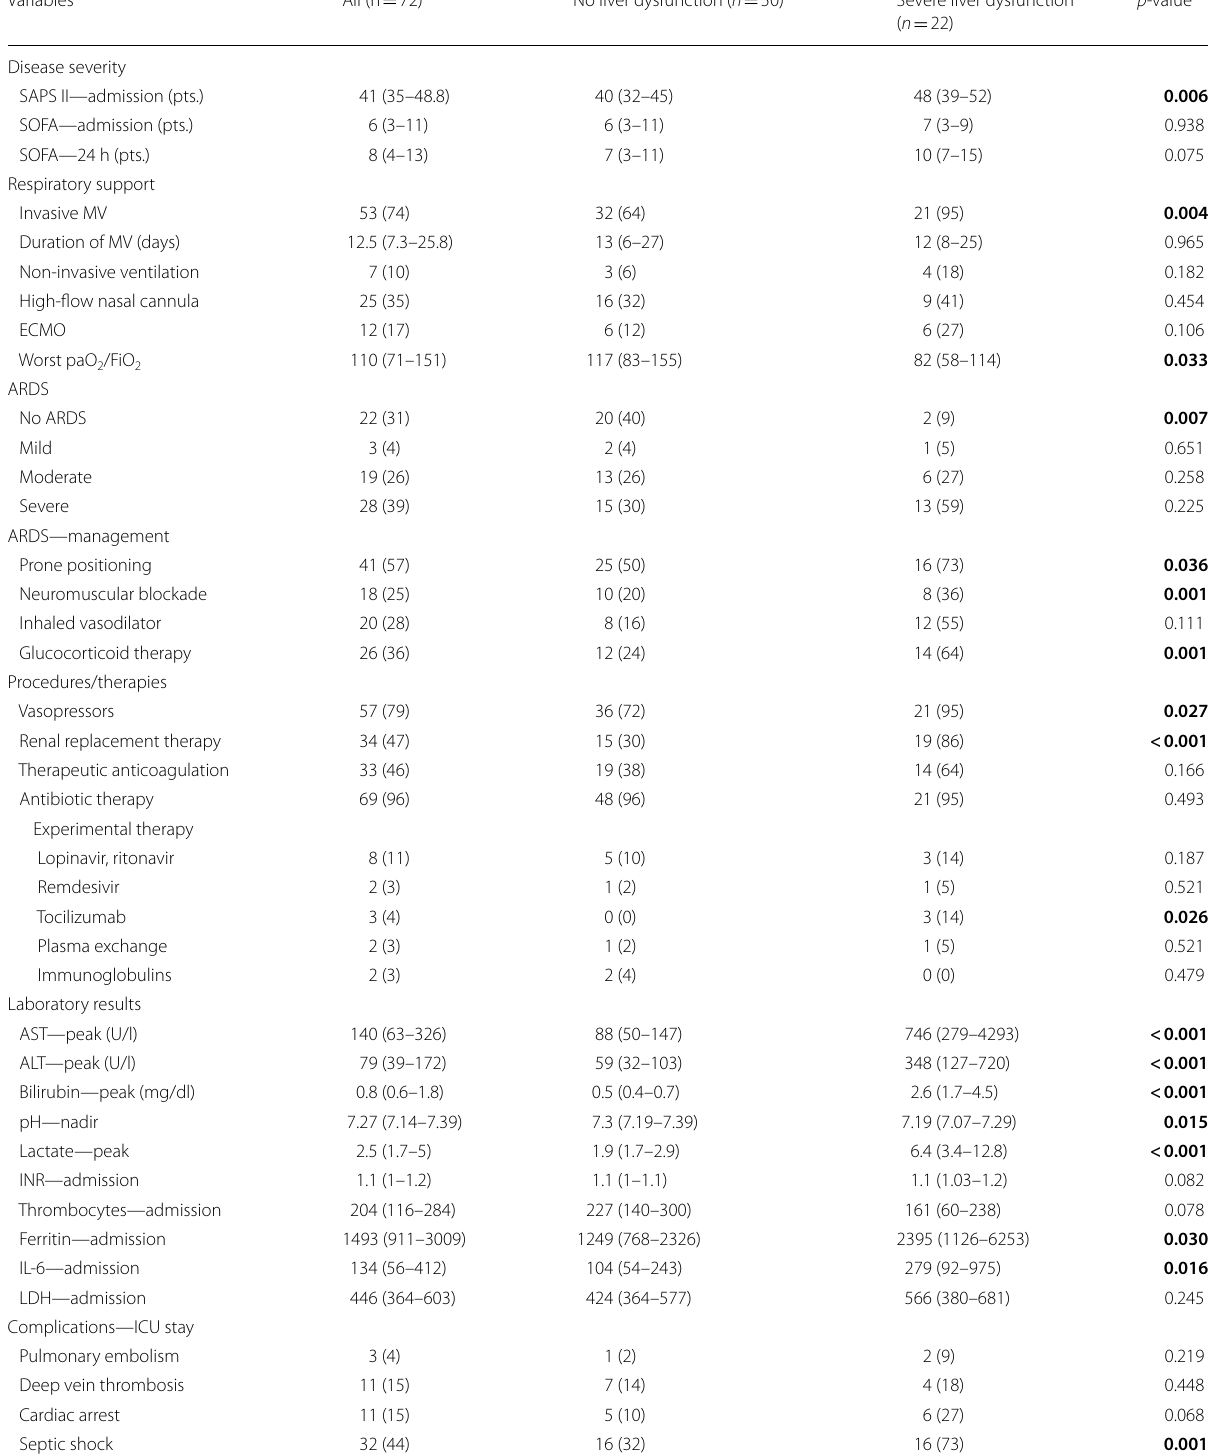
Table 2 ICU characteristics of patients with and without severe liver dysfunction Variables All (n